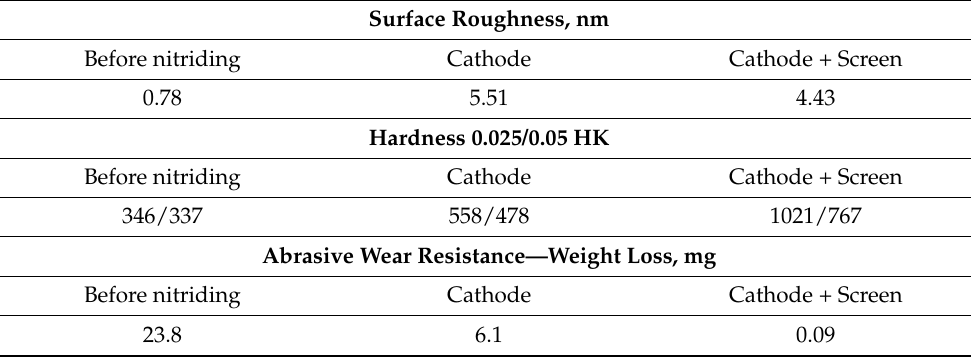
Table 3. Summary of roughness, hardness and wear resistance